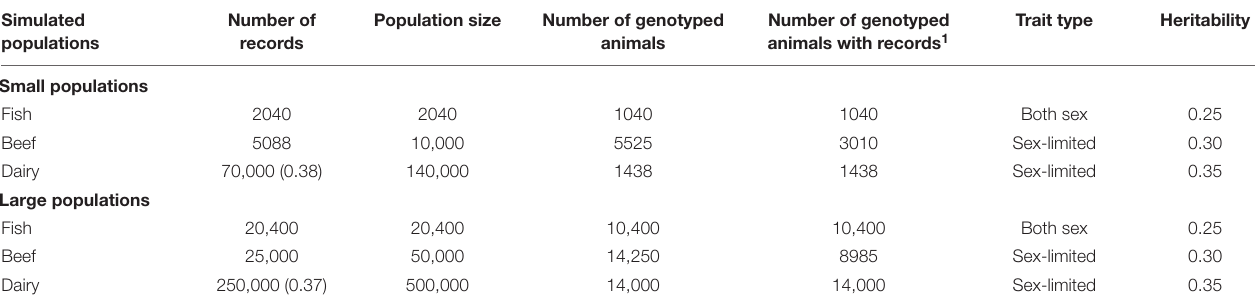
TABLE 1 | General parameters for the simulated populations 1 , 2